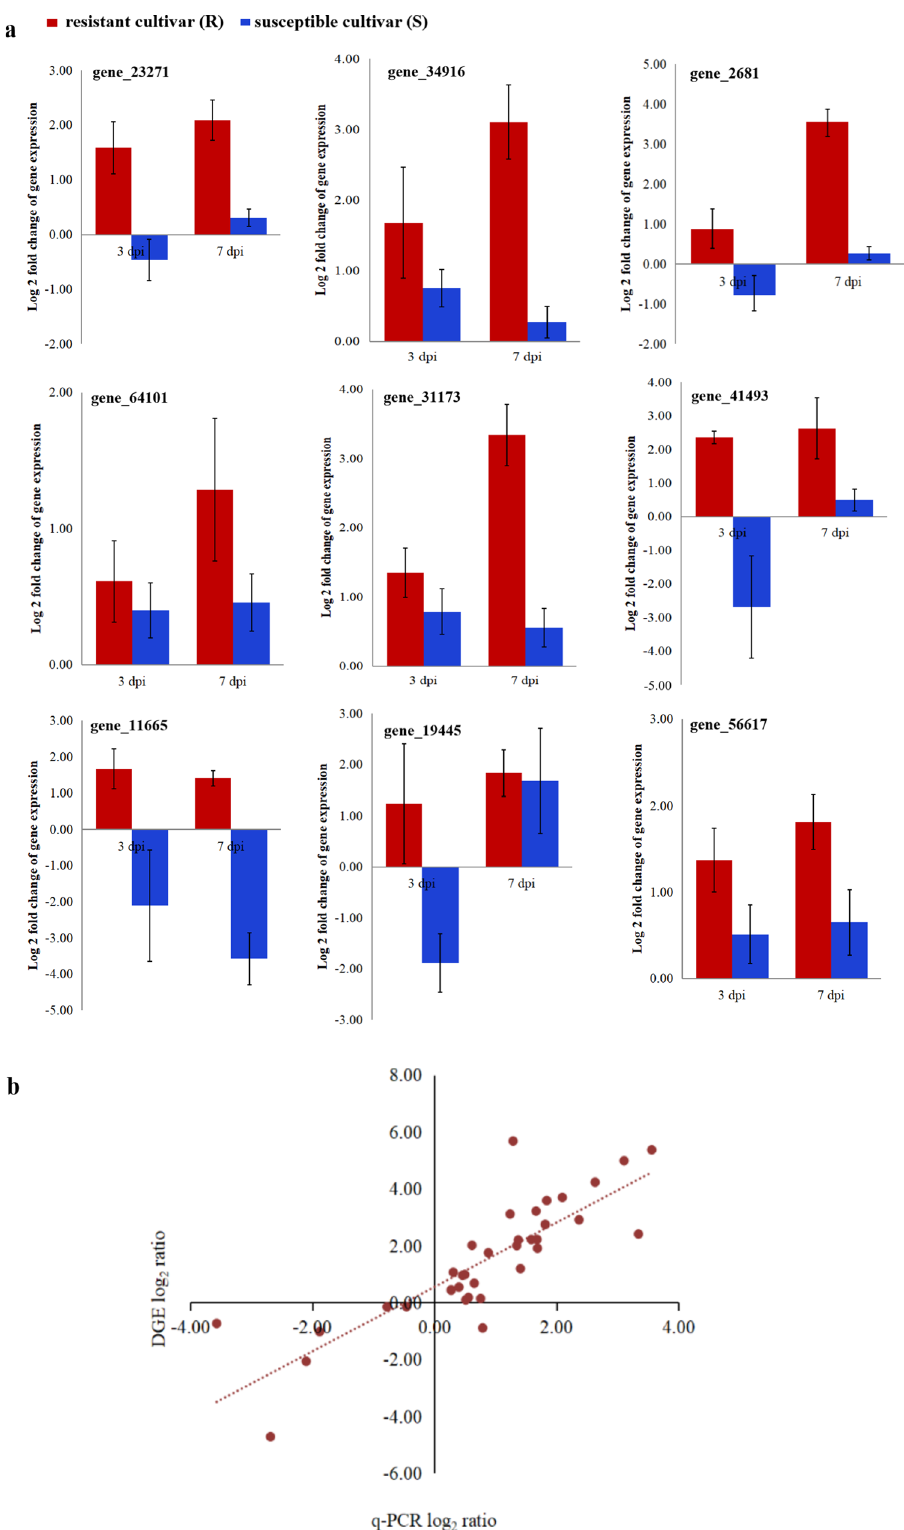
Figure 9. Verification of the digital gene expression (DGE) profile. Expression levels of the candidate differentially expressed genes obtained by qRT-PCR, calculated using the 2 − △△ Ct method with normalization to the internal reference L25 gene ( a ). The linear correlation between DGE profiles and qRT-PCR data ( b ). A correlation coefficient of 0.835 indicates an excellent linear correlation between the DGE profile and qRT-PCR